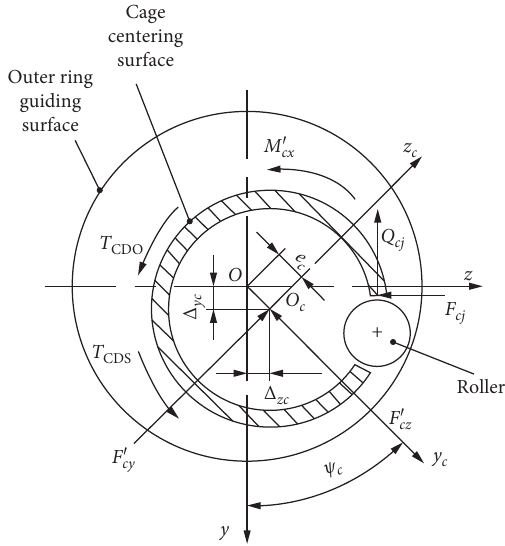
Figure 3: Schematic diagram of cage